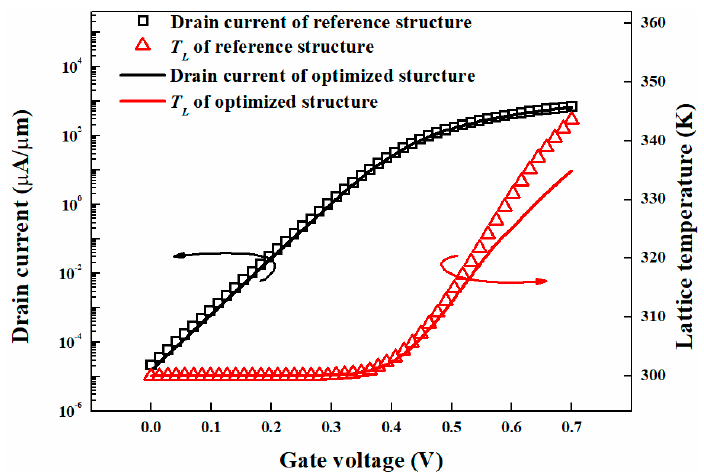
Figure 13. DC applied to the gate characteristics of the SHE, before and after optimization.